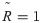
Mean convergence of fitness a cluster of N = 16 nodes and R˜=1 radius.